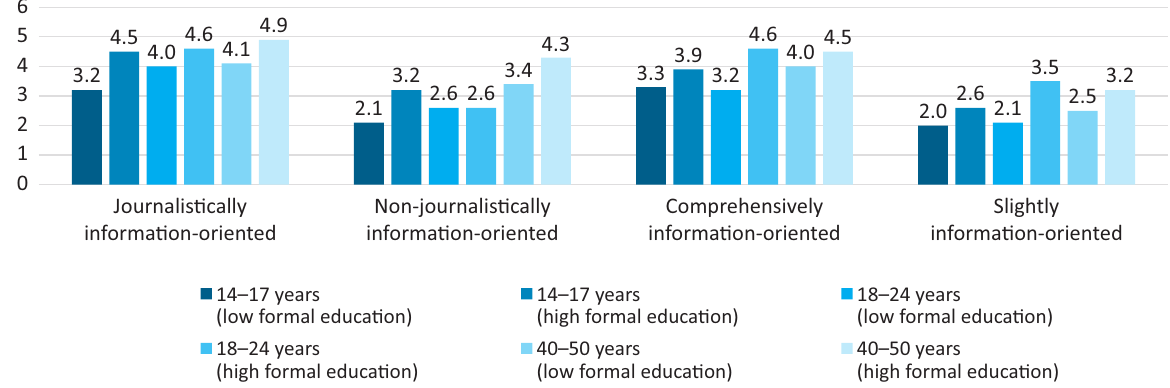
Figure 3. Socio‐political knowledge by type of information orientation, age group, and education. Notes: Mean values of correct answers from six knowledge questions; 14‐ to 17‐year‐olds—n = 494; 18‐ to 24‐year‐olds—n = 500; 40‐ to 50‐year‐ olds—n =